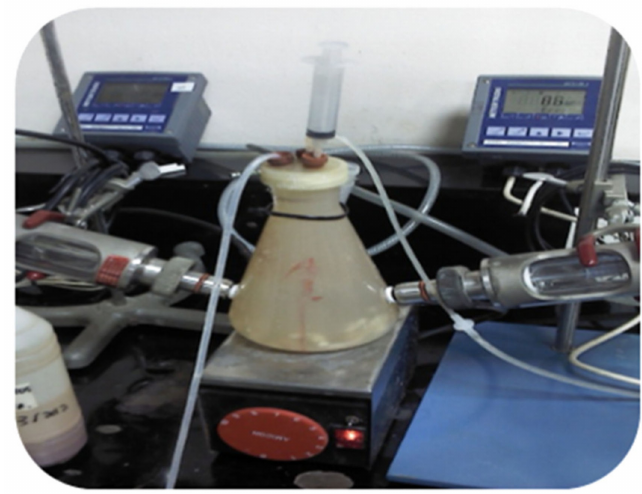
Figure 3. Photo illustrating the bioreactor setup with ORP and pH sensors.